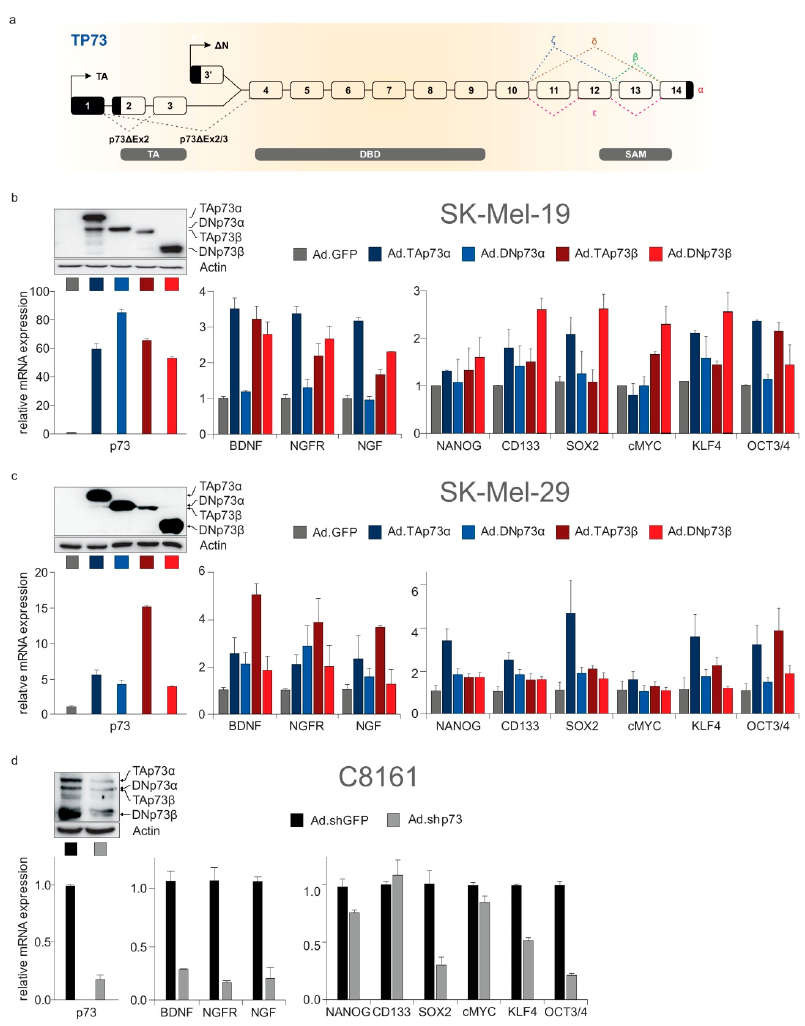
Figure 6. Products of the TP73 gene can simultaneously upregulate crucial stemness and neurogenesis mediators in melanoma. ( a ) Diagram depicting synthesis of isoforms from the TP73 gene. The p73 isoforms are produced by i) alternative splicing in the 3 ′ end, putting forth several C-terminal splice variants (designated α , β , γ , δ , ε , ζ ); or ii) the use of an extrinsic (P1) and alternative intrinsic promoter (P2) in the 5 ′ end, generating TA and ΔΝ classes of isoforms, and iii) alternative splicing in the 5 ′ end, resulting in truncated ΔΤΑ isoforms that partially or entirely lack the transactivation domain and, together with ΔΝ , constitute the DN isoforms. All isoforms contain a core DNA-binding domain. Different combinations of the N-terminal head with the C-terminal tail give rise to functionally distinct isoforms [34,36]. TA: transactivation domain, DBD: DNA-binding domain, SAM: sterile alpha motif. Melanoma progression is characterized by overexpression of the P1-derived p73 Δ Ex2/3 isoforms along with TAp73 α . ( b , c ) Sufficient transduction of the low-invasive, low-p73 expressing cell lines SK-Mel-19 ( b ) and SK-Mel-29 ( c ) with TAp73 or p73 Δ Ex2/3 isoforms (herein labeled as DNp73) is depicted by increased p73 protein (upper panel) and mRNA (left panel) levels relative to the GFP-transduced controls. The mRNA levels of neurotrophic (mid panel) and stemness factors (right panel) upon transduction of low-invasive, low-p73 expressing cell lines with adenovirus constructs expressing distinct p73 isoforms. ( d ) Same as ( b , c ) for the shRNA knockdown of p73 isoforms in the high-invasive, high-p73 expressing